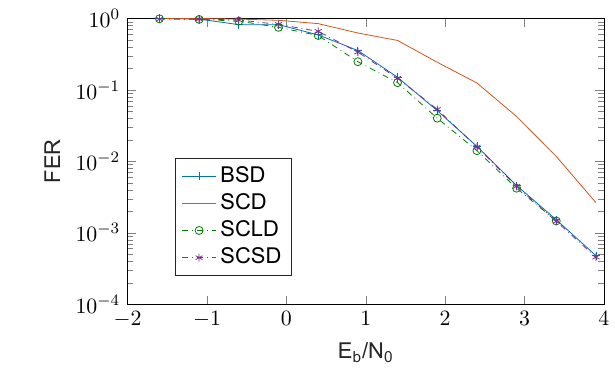
Figure 7 – FER of the (256 , 128) polar code using the BSD, SCD, SCLD and SCSD